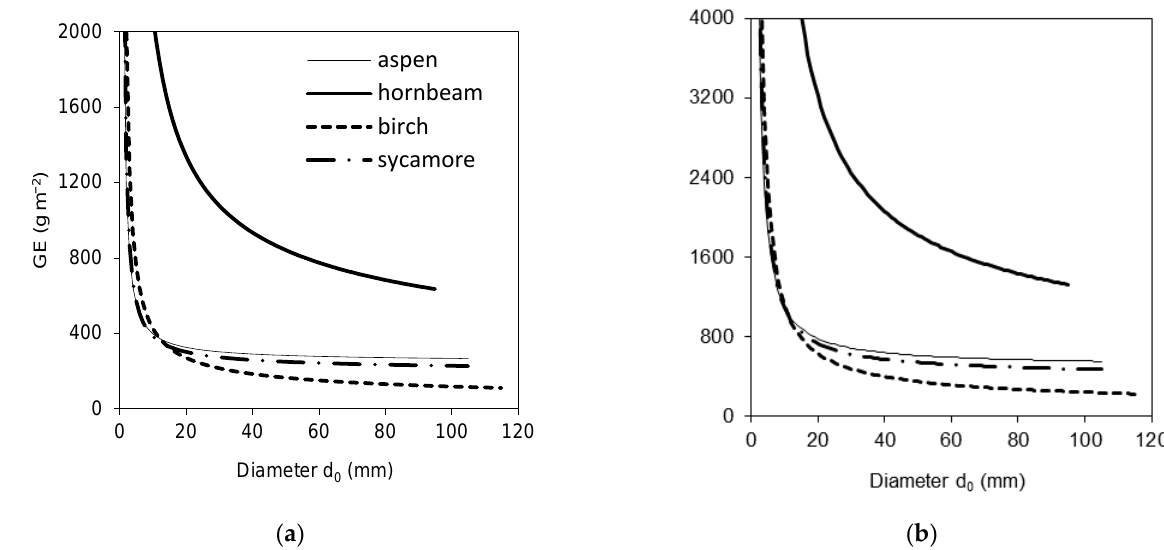
Figure 6. Species-specific growth efficiency (GE) presented against the initial diameter d 0 considering annual diameter increment of 5 mm ( a ) and 10 mm ( b ). Algorithms for calculation of the points on the curves are described in the Materials and Methods section (Equation (11)).